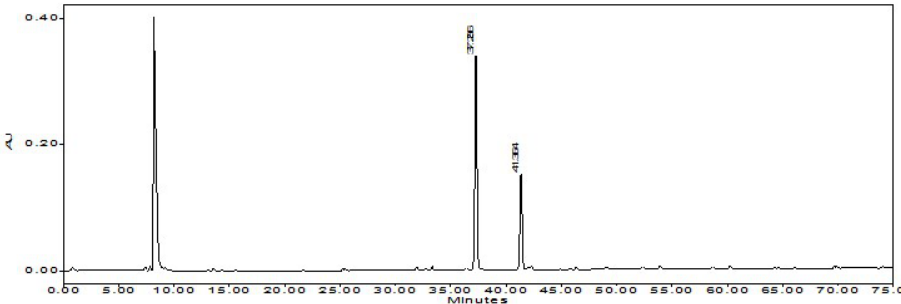
Figure 2. The chromatogram of reference compounds of capsaicin and dihydrocapsaicin.